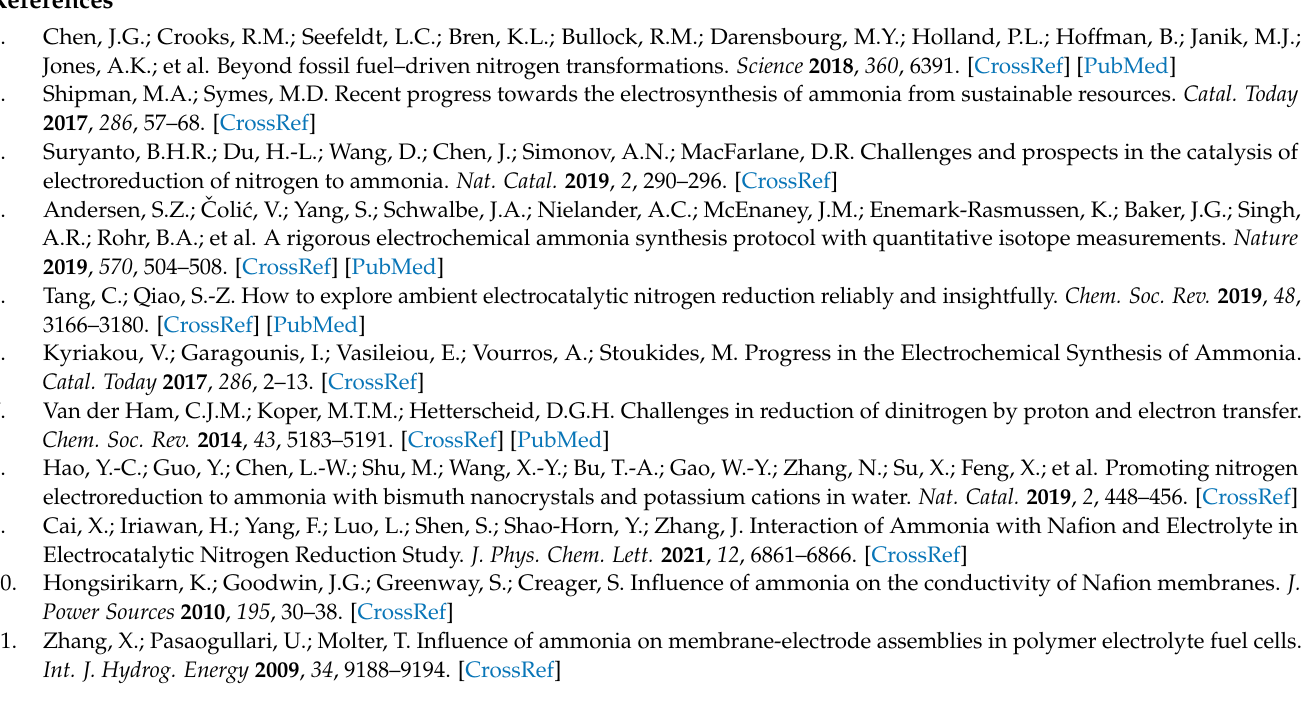
Figure S3: UV-Vis absorbance spectra time evolution for the ammonium ions absorption test in ammoniated water solution; (a) N117 membrane (b) ZP; Figure S4: UV-Vis absorbance spectra time evolution for the ammonium ions absorption test for N117 in (a) ammoniated water solution and the release experiment in (b) 0.1 M Na 2 SO 4 solution; Figure S5: Optical micrographs at low magnitude of the same samples (a) before and (b) after dipping in 1 ppm ammonia solution for 24 h. SEM micrographs of Zirfon (c) before and (d) after the same dipping test. Although the roughness